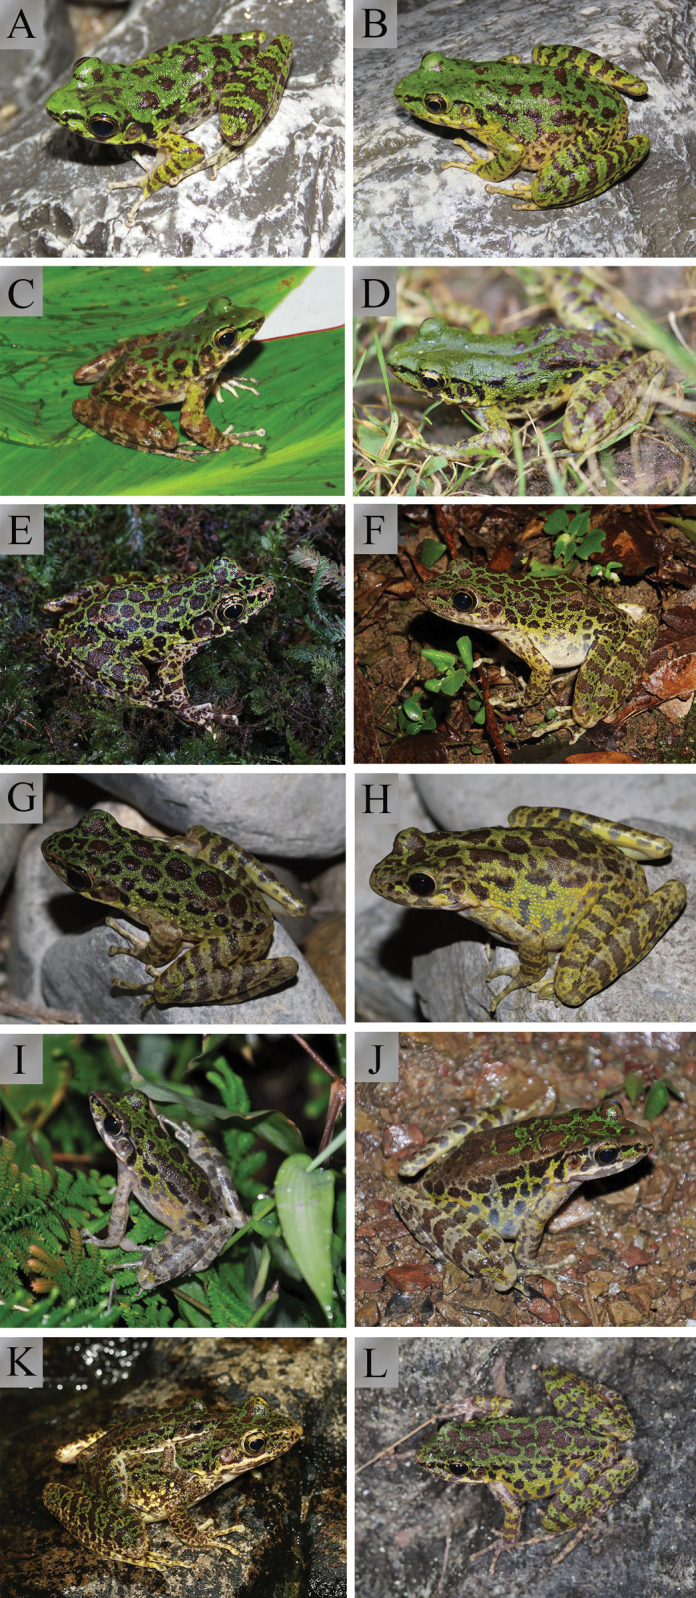
Comparisons of morphological characteristics with congeners AOdorrana
sangzhiensis sp. nov. (male, photo by Bing Zhang in the type locality) BOdorrana
sangzhiensis sp. nov. (female, photo by Bing Zhang in the type locality) COdorrana
hejiangensis (male, photo by Shize Li in Chishui City, Guizhou Province, China) DOdorrana
hejiangensis (female, photo by Bo Cai in the type locality) EOdorrana
huanggangensis (male, photo by Shengchao Shi in the type locality) FOdorrana
huanggangensis (female, photo by Shengchao Shi in the type locality) GOdorrana
kweichowensis (male, photo by Shize Li in the type locality) HOdorrana
kweichowensis (female, photo by Shize Li in the type locality) IOdorrana
schmackeri (male, photo by Liang Qiao in Wushan County, Chongqing City, China) JOdorrana
schmackeri (female, photo by Liang Qiao in Wushan County, Chongqing City, China) KOdorrana
tianmuii (male, photo by Yufan Wang in the type locality) LOdorrana
tianmuii (female, photo by Yufan Wang in the type locality).